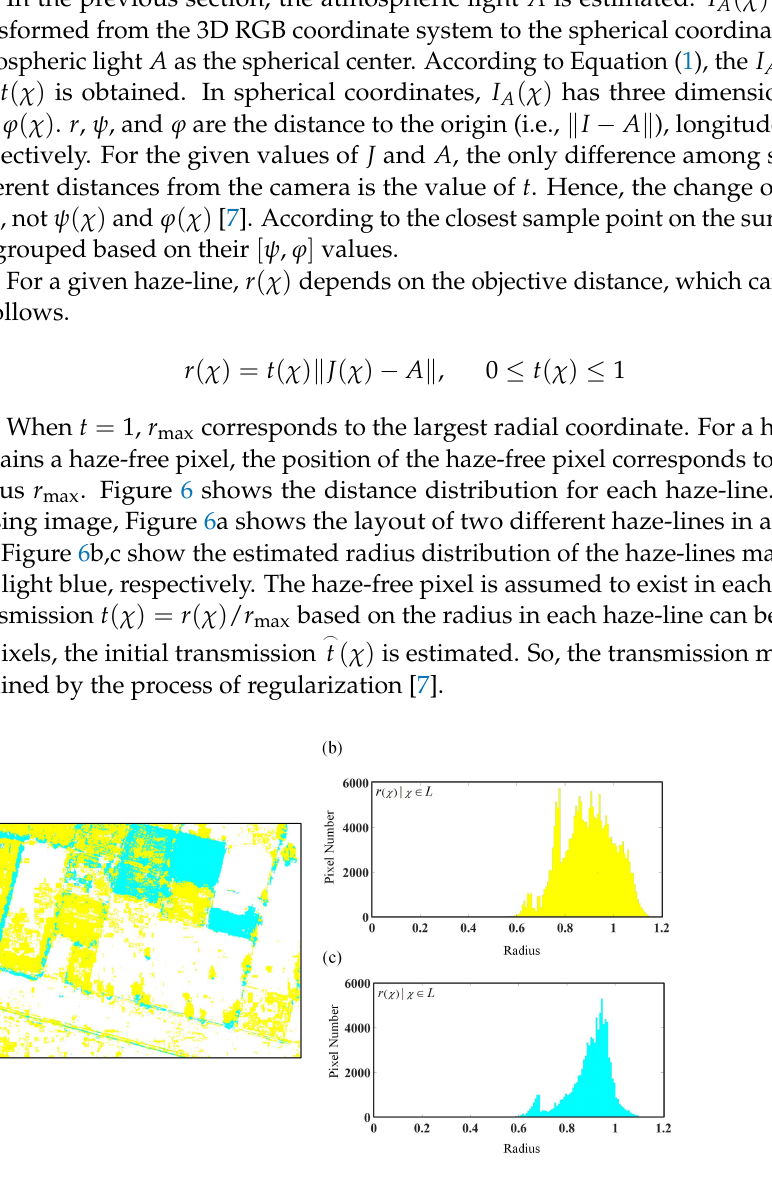
Figure 6. Distance distribution per haze-line of a sample image. ( a ) Pixels belonging to two different haze-lines are depicted in yellow and light blue, respectively. ( b , c ) A histogram of r ( χ ) within each cluster for yellow and light blue haze-lines, respectively. The horizontal axis is limited to the range [ 0, (cid:107) A (cid:107) ] , as no pixel can be out of the radius range in this sample